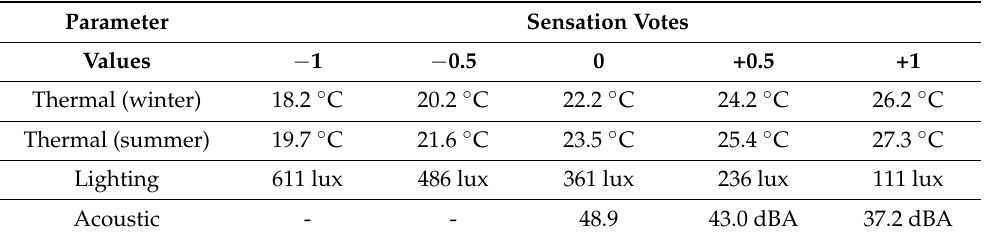
Figure 6. ( a ) TSV vs. T op winter season; ( b ) TSV vs. T op summer season, ( c ) ASV vs. SPL, ( d ) LSV vs. lighting. Table 5. Values calculated for the comfort zones based on the sensation votes. Parameter Sensation